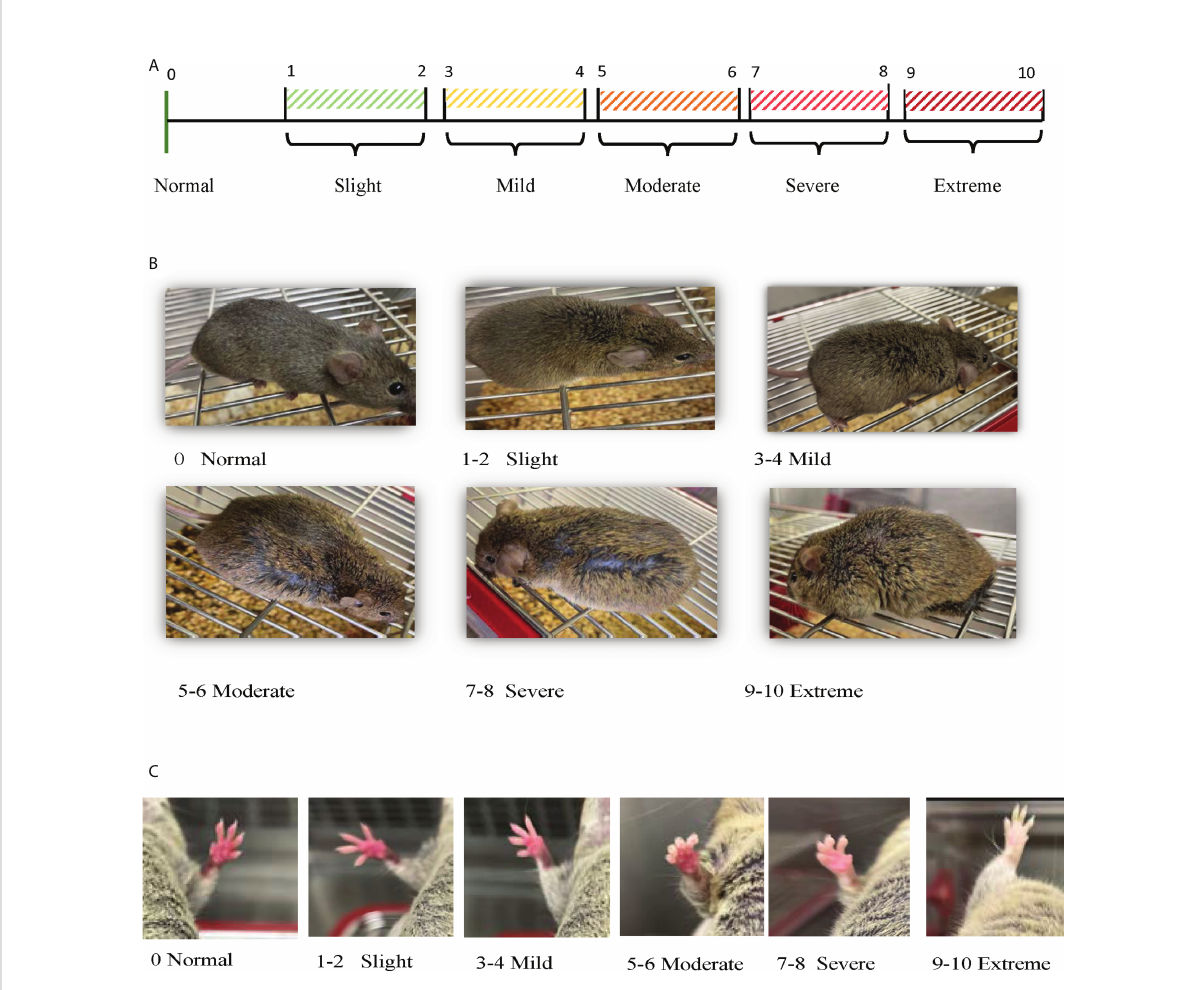
FIGURE 1 Scoring physical observations. (A) Scoring Scale: Numeric rating scale (0 -10-point scale) was used to score the observed changes in the physical status, which include swelling/edema, moving disability and paleness of paws, where 0 indicates no symptom, 1-2 light, 3-4 mild, 5-6 moderate, 7-8 severe, or 9-10 extreme. (B) Scoring Swelling: Numeric rating scale (0 -10-point scale) used to score the observed swelling/ edema in each mouse during the experimental time (8 – 16 weeks ± 1 week). (C) Scoring Paw Skin Coloration: Numeric rating scale (0 -10- point scale) used to score the observed paw skin color changes in each mouse during the experimental time (8 – 16 weeks ± 1